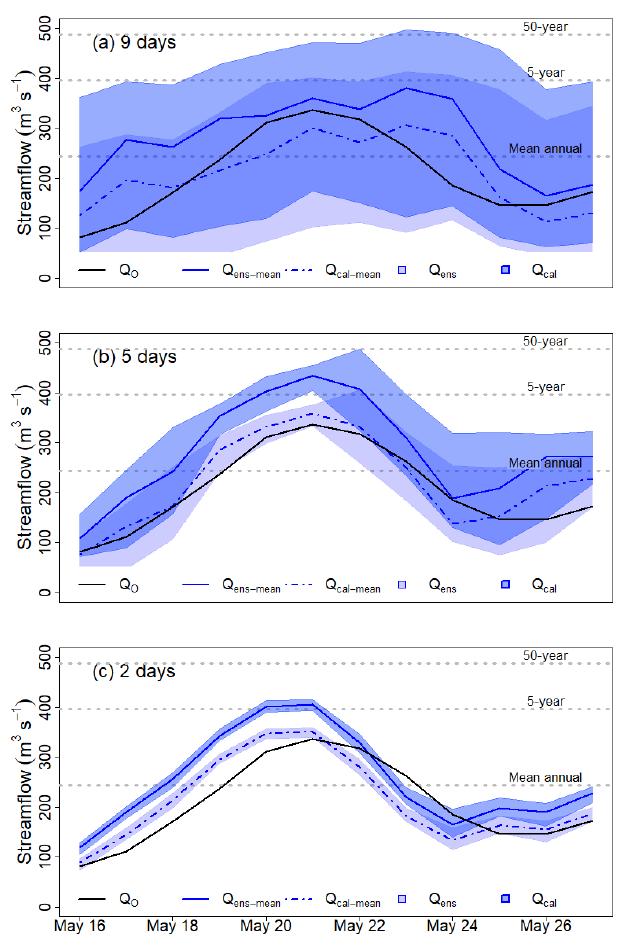
Figure 10. Forecasted streamflow for the Bulken catchment fort lead times of 9, 5, and 2 days. Forecast target dates on the x axis, and streamflow (m 3 s − 1 ) on the y axis. Reference streamflow with seNorge observations Q o (black solid line), ensemble mean uncali- brated temperature Q ens (blue line), ensemble mean calibrated Q cal (blue dotted line), ensemble range Q ens (light violet area), and en- semble range Q cal (light blue area). The grey dotted lines indicate the thresholds for mean annual, 5-year, and 50-year